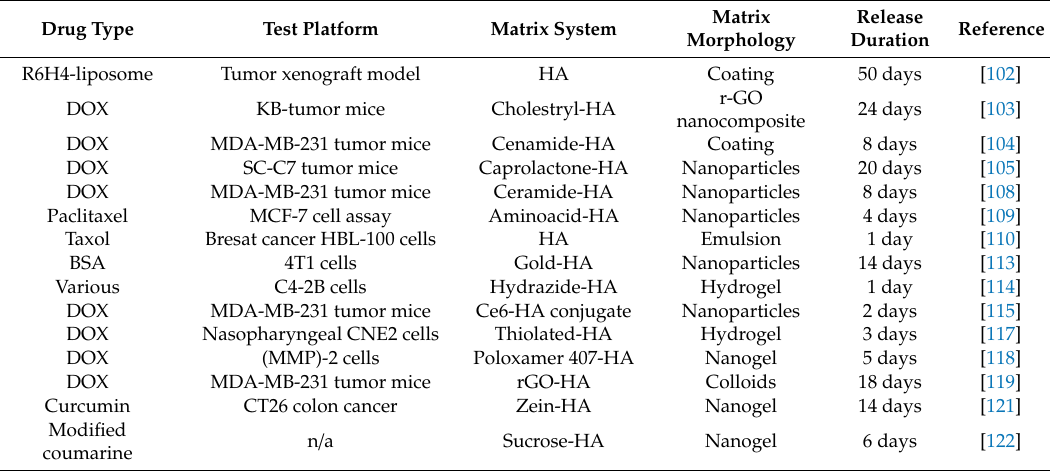
Table 3. Summary of cancer targeting release systems based on HA. Please see text for various abbreviations and the listed